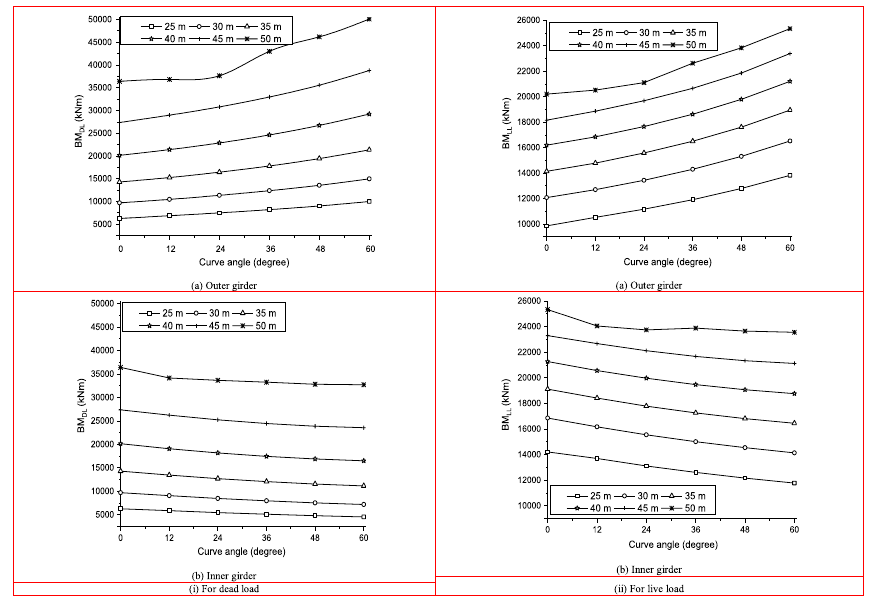
Fig. 9 Variation of bending moment with curve angle for different span. a Outer girder. b Inner girder. (i) For dead load. (ii) For live